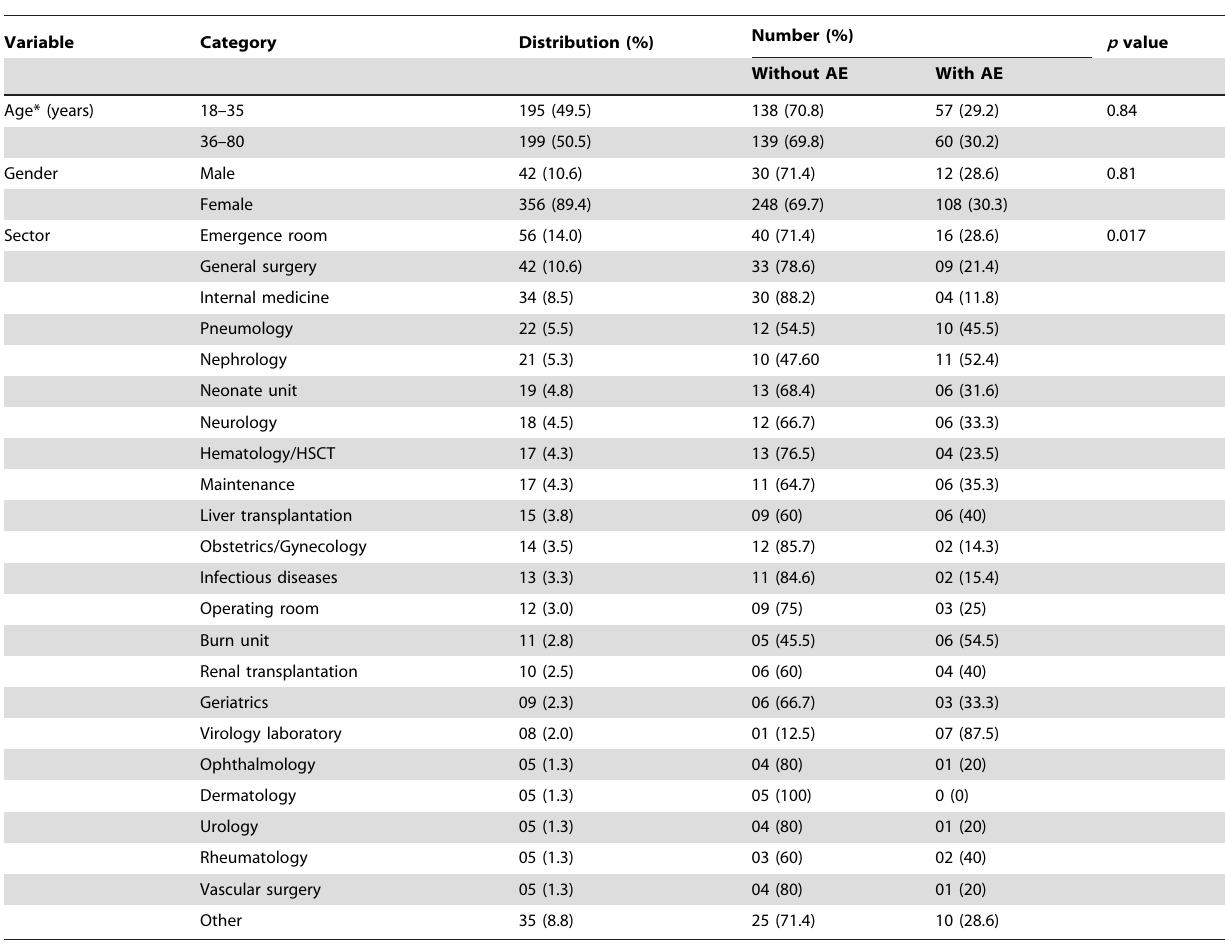
Table 1. Demographic characteristics of HCWs surveyed for adverse events (AE).